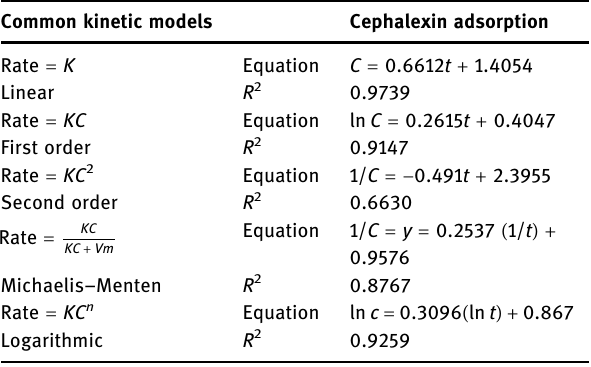
Table 3: The kinetics of cephalexin adsorption by optimum com - posite hydrogels ( the R 2 and main coe ffi cients for correlated gen - eral absorption models ) Common kinetic models